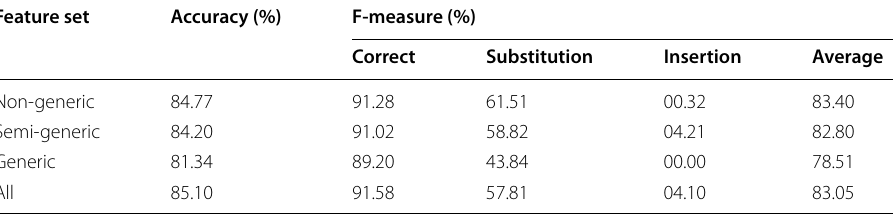
Table 6 V-RNN classification accuracies and F-measures of error type classification obtained based on generic versus semi-generic and non-generic